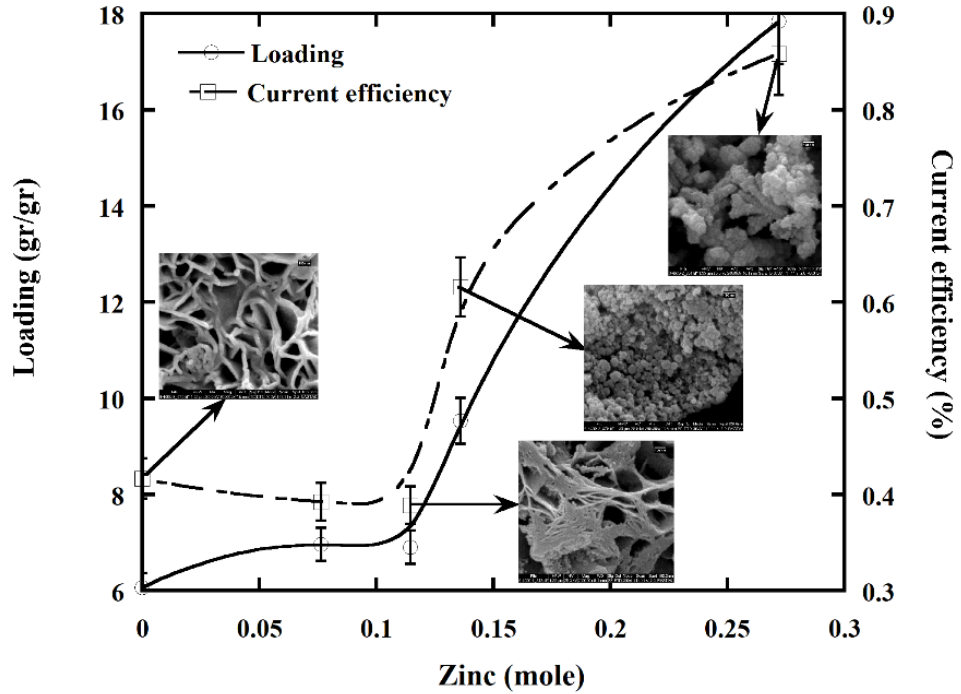
Figure 7. S hows the loading and current efficiency versus the amount of zinc mole on the bath for 3 h coating time. In each section, the structure of the electron microscope Image corresponding to that section is given at the